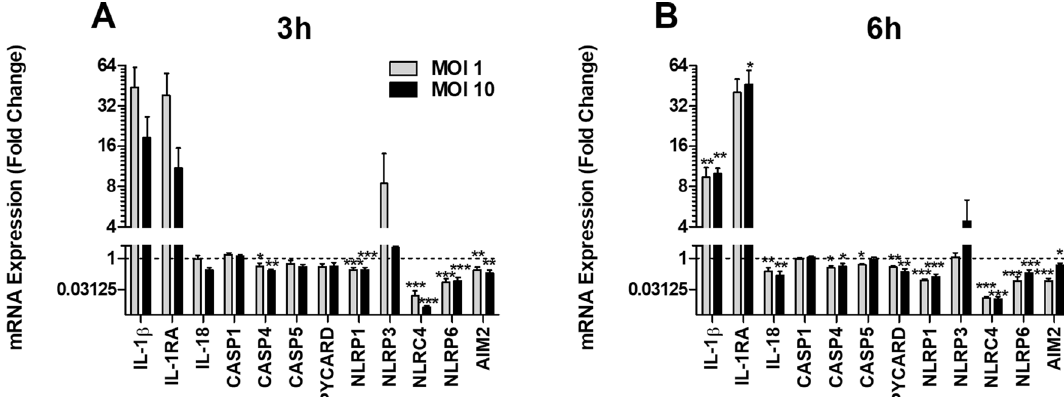
Figure 1. Gene expression of inflammasome-related genes. Human neutrophils were infected with UPEC strain CFT073 at MOI 1 or MOI 10 for 3 h ( A ) and 6 h ( B ) followed by analysis of mRNA expression. The gene expression was normalized to GAPDH and expressed as fold change relative to unstimulated controls. Data are presented as mean ± SEM (n = 3 independent experiments) with the y-axis as Log2. Bars below 1 (the dotted line) indicate decreased gene expression. Asterisks denote statistical significance compared to respective unstimulated control (*p < 0.05, **p < 0.01, ***p <